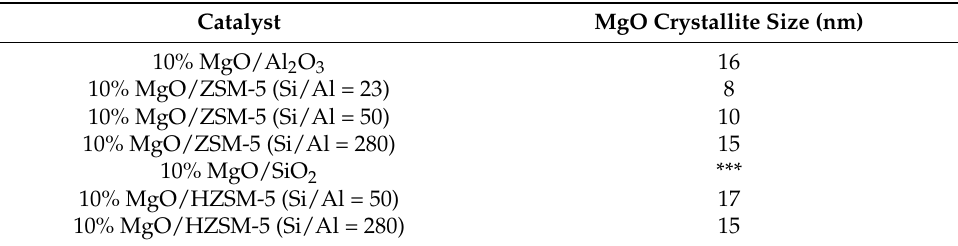
Table 4. Crystallite size of the active phase (MgO) of catalysts supported on ZSM-5 zeolite and oxide supports calculated from XRD data using Scherrer equation.